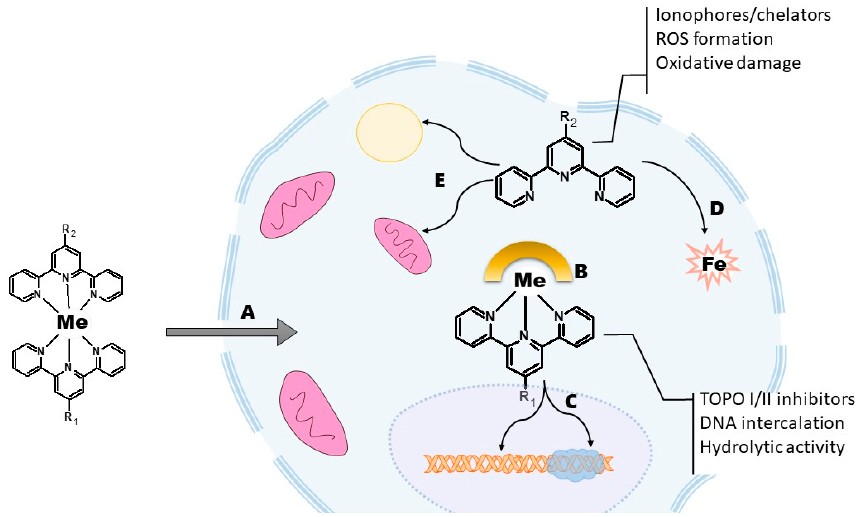
Figure 7. General depiction of intricate interactions between Tpy complexes and cellular environment that may lead to dissociation ( A ) and ligand exchange ( B ). Liberated molecules of Tpy and mono-complexes may further interact with targets exerting their activity in different manner. Complexes tend to intercalate and hamper the topoisomerases ( C ), while free ligands may act as chelating agents and ionophores generating ROS ( D ) and disturb the metabolic balance ( E ).